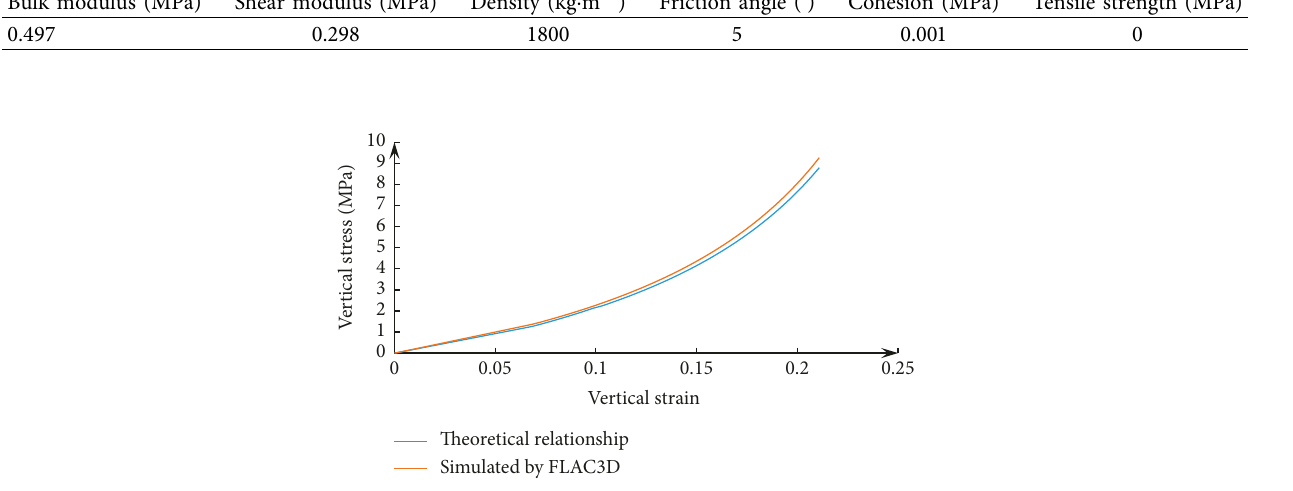
Figure 11: Relationship between the vertical stress and vertical